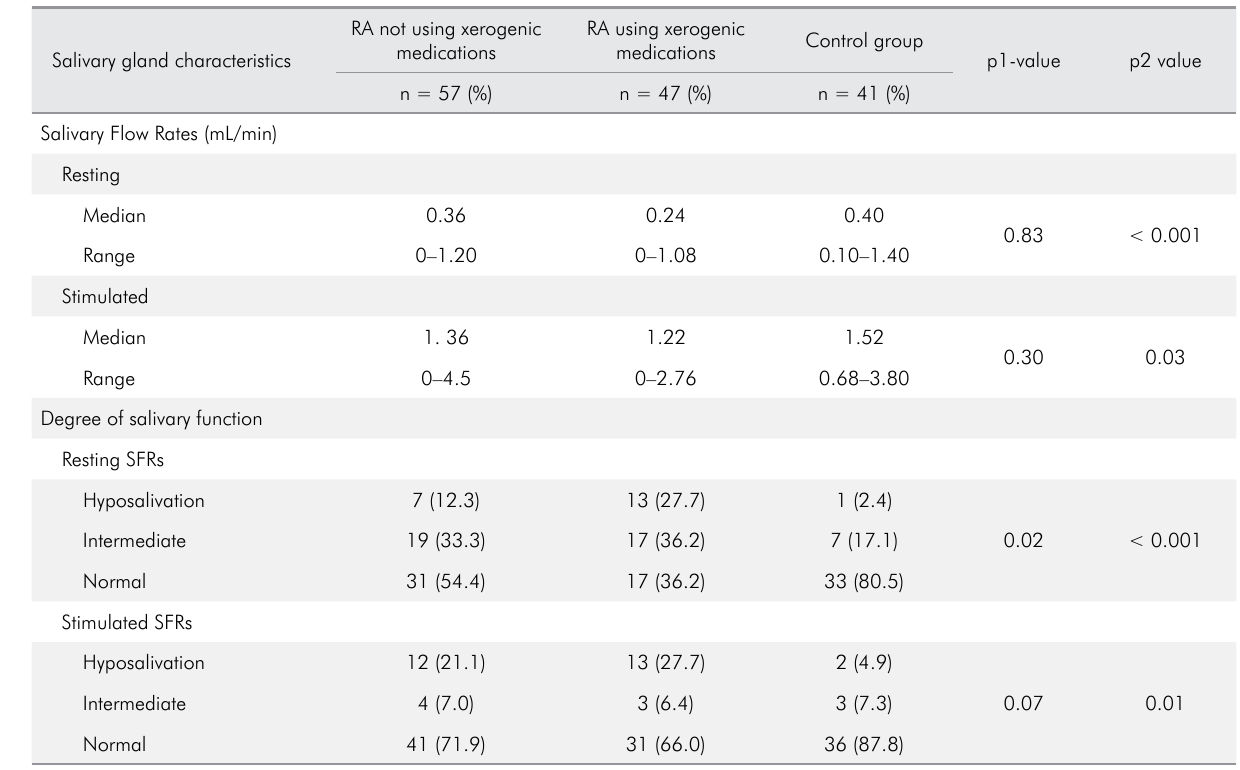
SFR: salivary flow rates; RA: Rheumatoid arthritis; p1: differences between RA not using xerogenic medications and controls; p2: differences between RA using xerogenic medications and controls; p1 and p2 were adjusted for two comparisons (p < 0.025).